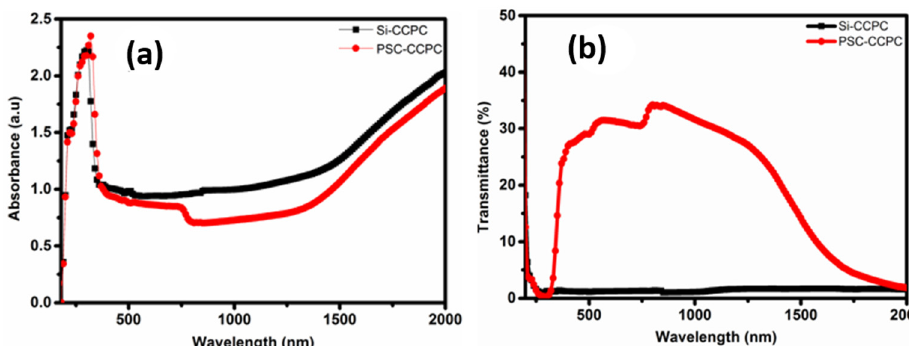
Figure 5. The plot of ( a ) absorbance and ( b ) transmittance spectra of CCPC-integrated-PSC compared with CCPC integrated single crystalline silicon cell, consisting of a similar active area of 1 cm 2 .